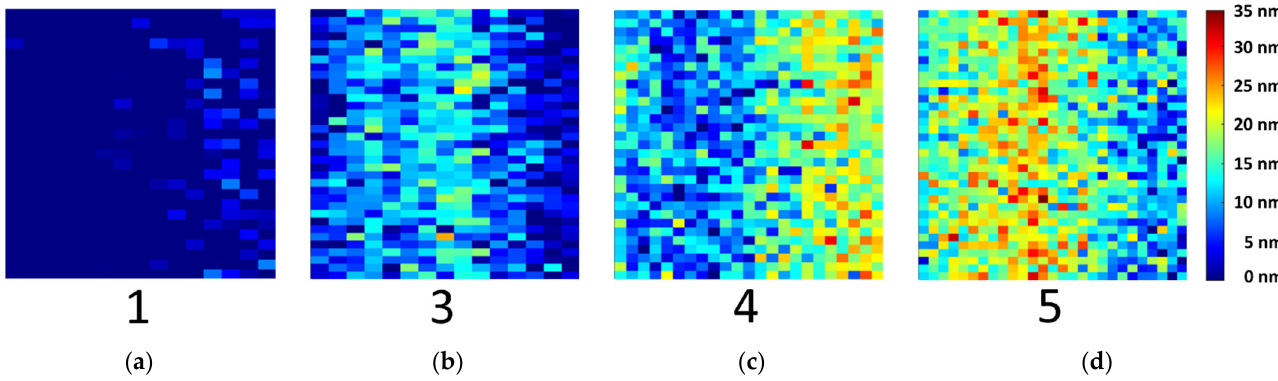
Figure 8. Distribution map predicted from the three-factor PLS-R model of the UV hyperspectral imaging data. The oxide layer thicknesses for each pixel of samples ( a ) sample type 1, ( b ) sample type 3, ( c ) sample type 4 and ( d ) sample type 5 were calculated for model prediction.